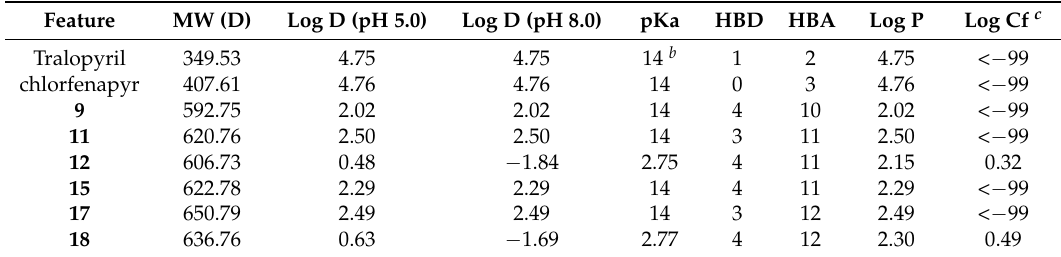
Table 2. Predicted physicochemical descriptor MW, log D, pKa, HBD, HBA of tralopyril, chlorfenapyr, 9 , 11 , 12 , 15 , 17 and 1 8 a .